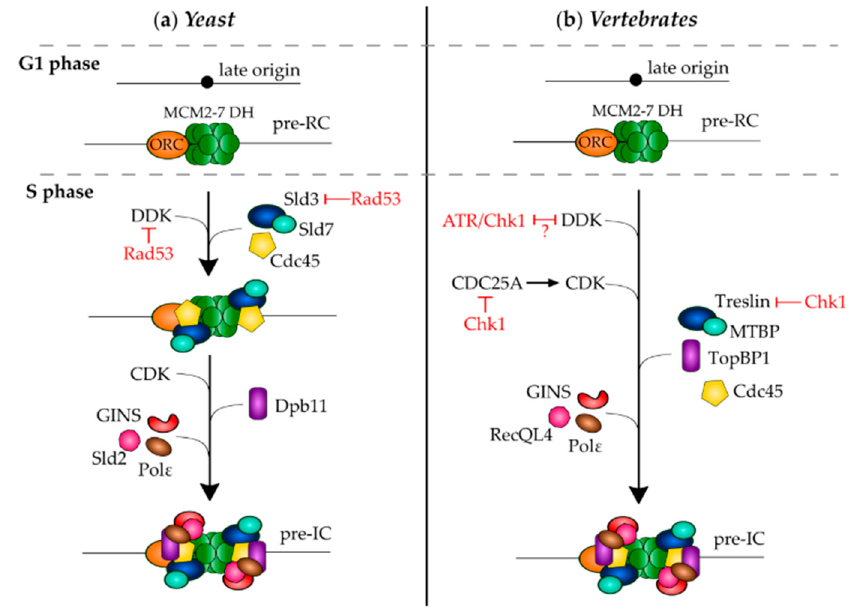
Figure 2. Mechanisms for inhibition of preIC assembly on late origins by the intra-S phase checkpoint in ( a ) budding yeast and ( b ) vertebrates. Rad53 phosphorylates and inhibits Dbf4 and Sld3 in budding yeast. In vertebrates, Chk1 inhibits Treslin mediated Cdc45 recruitment and Cdc25 mediated CDK activation. Inhibition of DDK activity by ATR/Chk1 is unclear (see text).